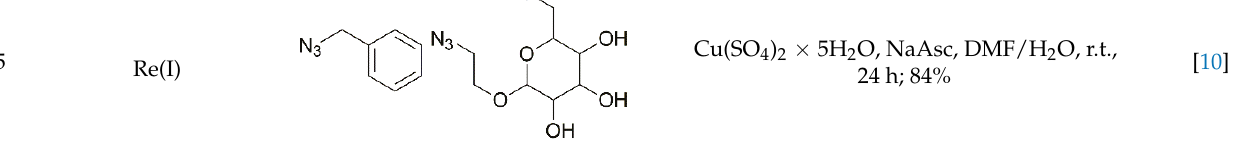
Table A1. Some literature examples of C ≡ C peripherally functionalized metallocenters, azide sub- strates and click-reaction conditions.